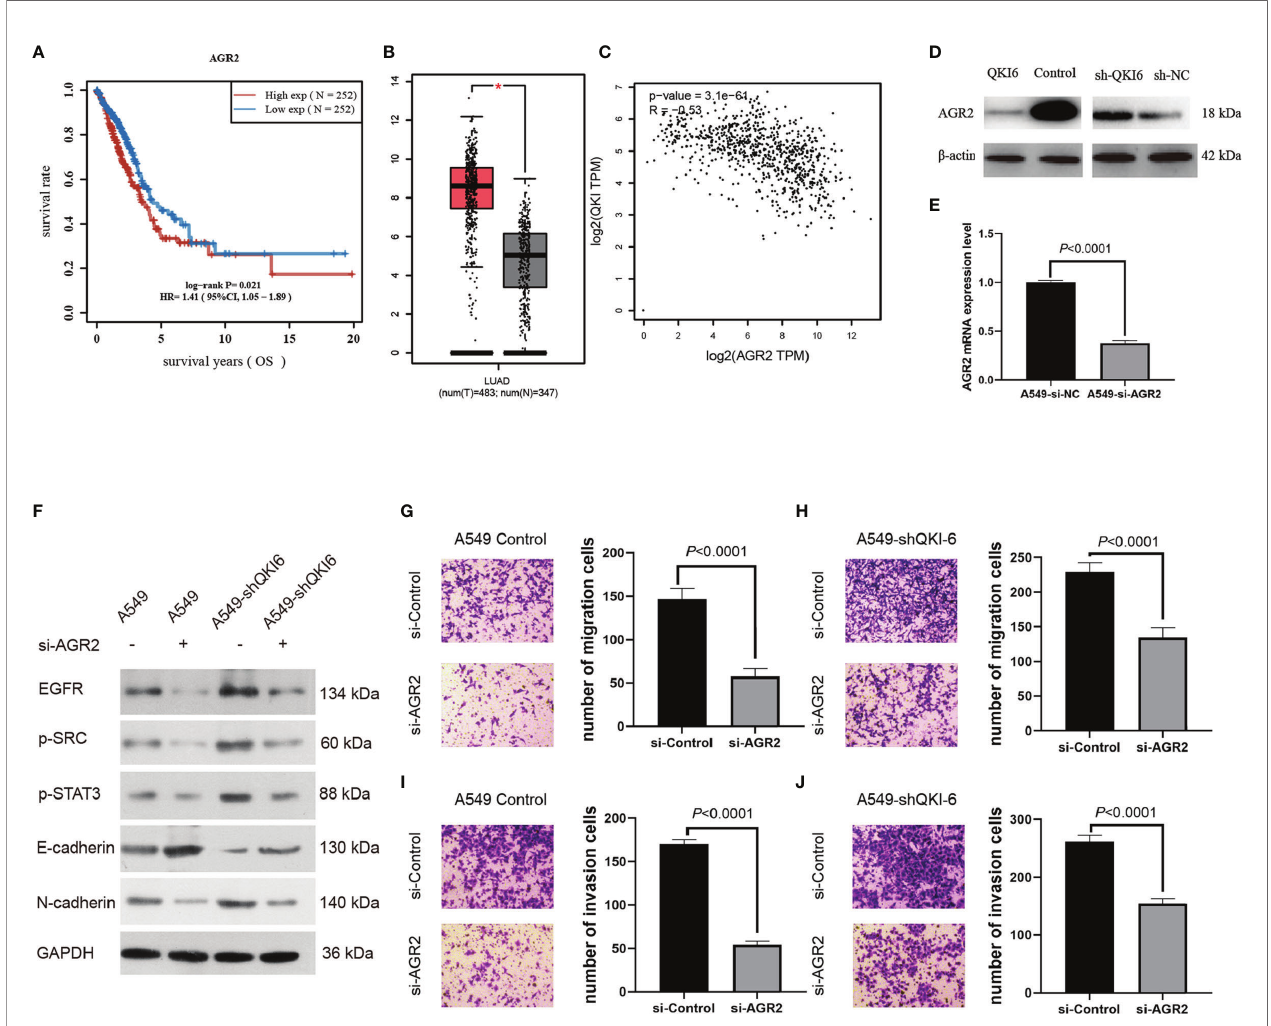
FIGURE 5 | QKI-6 knockdown promotes NSCLC cell migration by inducing EMT via AGR2 upregulation. (A) Kaplan – Meier overall survival analysis of AGR2 expression in patients with NSCLC by using the TCGA samples ( n = 504, P = 0.021, log-rank test). (B) AGR2 expression levels were analyzed in the NSCLC and normal control groups by using the TCGA and GTEx samples (red = tumor, n = 483; gray = normal, n = 347). (C) QKI expression was negatively correlated with that of AGR2 ( P < 0.0001, r = − 0.32, Spearman ’ s test). (D) Western blot analysis of AGR2 expression in QKI-6 overexpression A549 cell lines, QKI-6 shRNA A549 cell lines, and normal A549 cell lines. (E) AGR2 mRNA level was detected by qRT-PCR. (F) Effects of AGR2 knockdown in A549 and A549-shQKI-6 cells on p-SRC, p- STAT3, and EMT markers (E-cadherin, N-cadherin) detected by Western blot. GAPDH was used as an induced loading control. (G, H) Representative images and results of Transwell migration assays. (I, J) Representative images and results of Transwell invasion assays. Data in (G – J) are shown as the mean ± standard error from three independent experiments. * P <